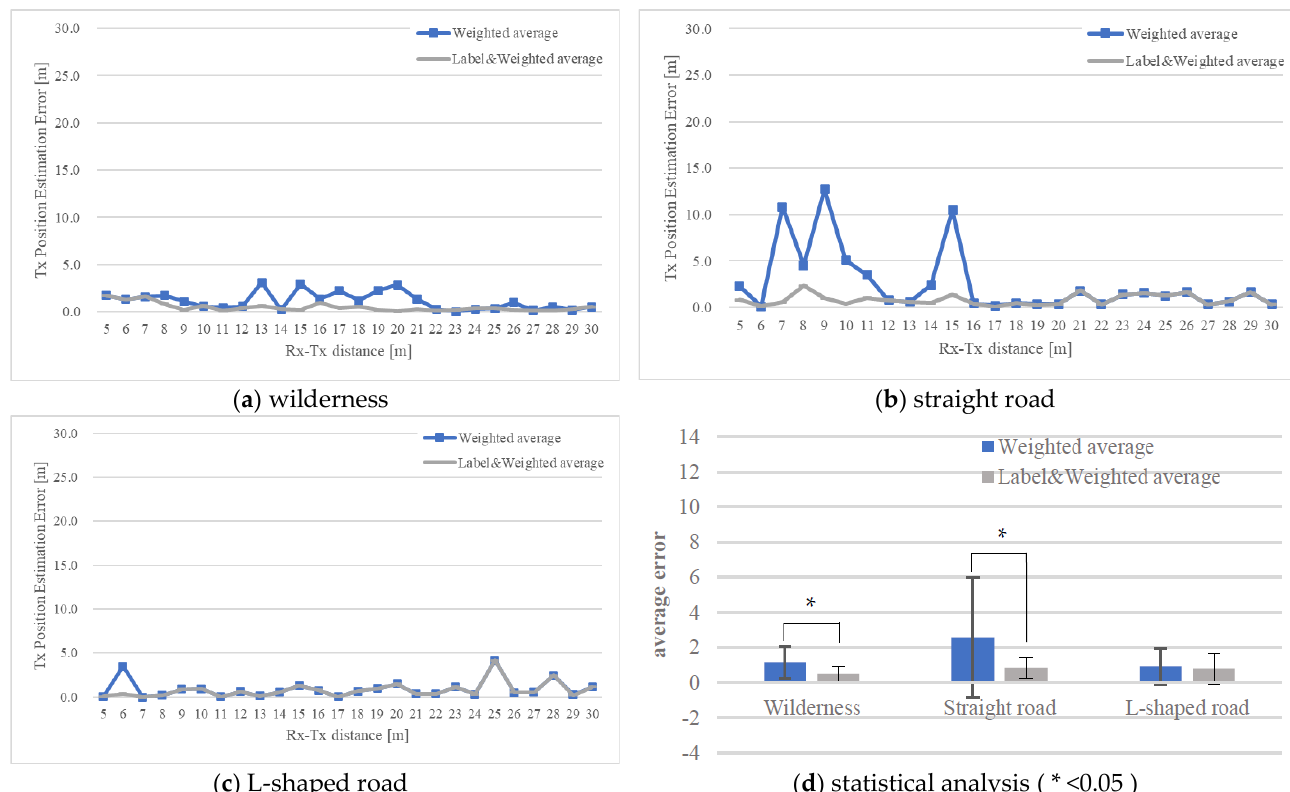
Figure 8. Position estimation results of the measurement simulation using the particle filter (three- step RSSI measurement). ( a ) wilderness; ( b ) straight road; ( c ); L-shaped road; ( d ) statistical analysis.